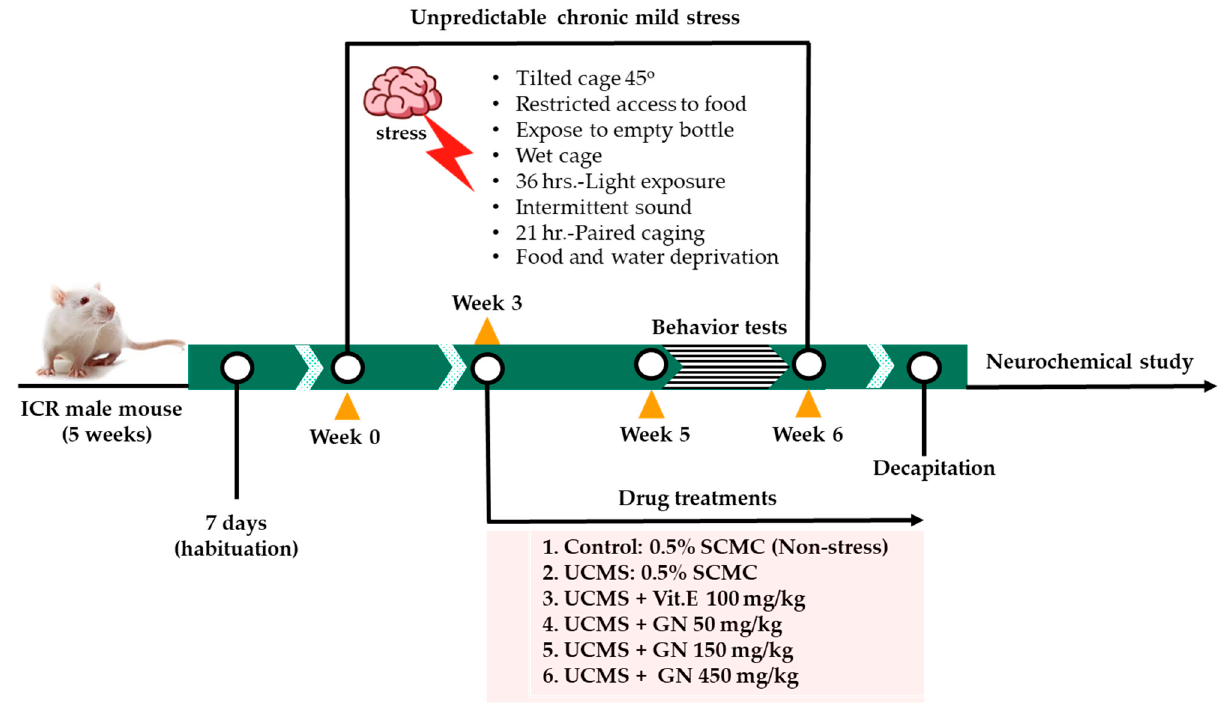
Figure 7. A schematic diagram of the animal experimental design in this